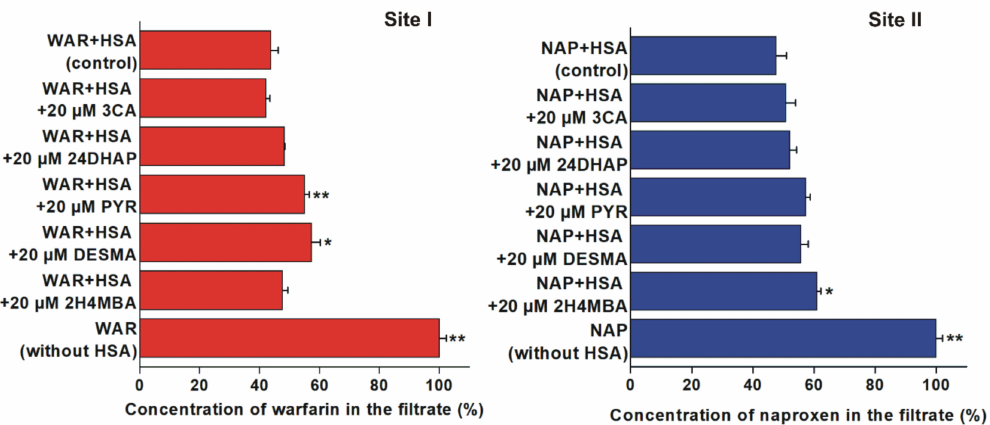
Figure 5. Displacement of warfarin (WAR; left) and naproxen (NAP; right) from HSA based on ultrafiltration (*p < 0.05, **p < 0.01). Left: Concentration of WAR in the filtrate after ultrafiltration in the absence and presence of 3-coumaric acid (3CA), 2,4-dihydroxyacetophenon (24DHAP), pyrogallol (PYR), O -desmethylangolensin (DESMA), and 2-hydroxy-4-methoxybenzoic acid (2H4MBA) (WAR: 1 µ M; HSA: 5 µ M). Right: Concentration of NAP in the filtrate after ultrafiltration in the absence and presence of 3CA, 24DHAP, PYR, DESMA, and 2H4MBA (NAP: 1 µ M; HSA: 1.5 µ M). Means and SEM values presented are derived from three independent experiments.